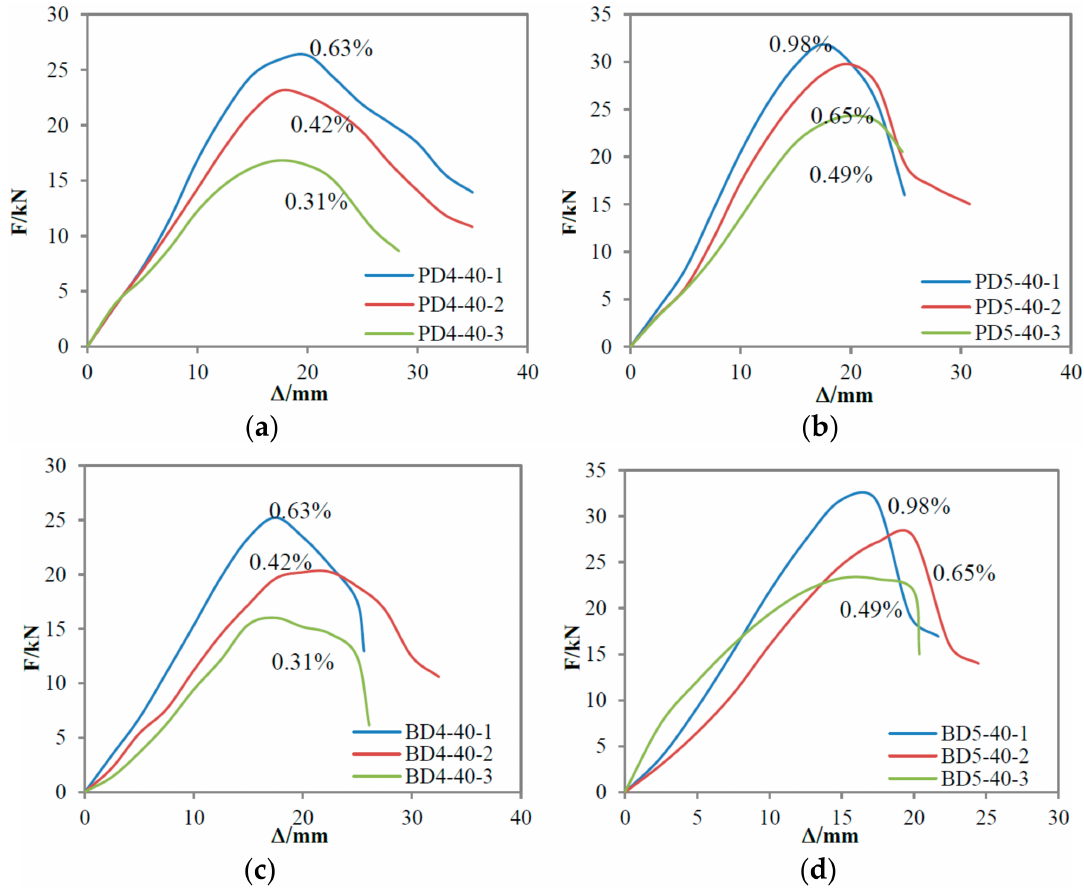
Figure 9. Influence of reinforcement ratio on the bearing capacity of specimens. ( a ) Ordinary concrete wallboard with D = 4; ( b ) Ordinary concrete wallboard with D = 5; ( c ) Recycled concrete wallboard with D = 4; ( d ) Recycled concrete wallboard with D =